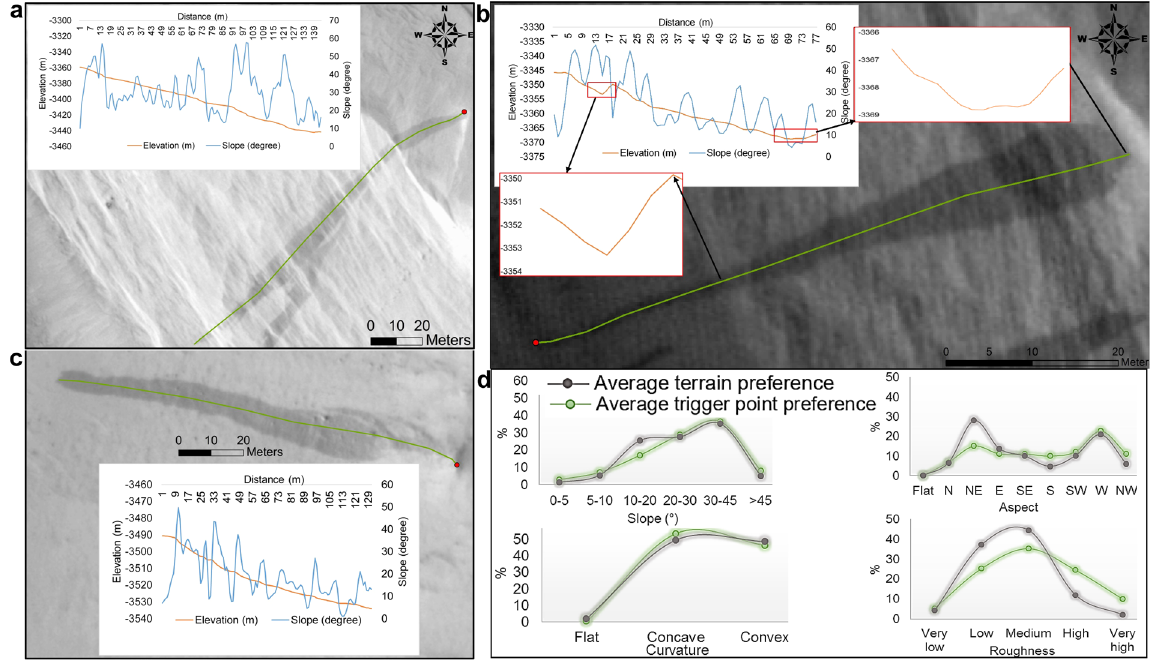
Figure 4. Terrain preferences and slope characteristics revealed by HiRISE images and DTMs. ( a , b and c ) Slope streaks over widely variable slopes. Red dots represent the point of initiation and green curves are used for the transect analysis of the terrain. The highlighted plots within red rectangles in Fig. 4b show the slope streak movement against gravity. ( d ) Geomorphometric preferences displayed by the slope streaks. The Maps are created using ArcGIS Version 10.4 (http://desktop.arcgis.com/en/arcmap/latest/get-started/setup/arcgis- desktop-quick-start-guide.htm). HiRISE image credit: NASA/JPL/University of